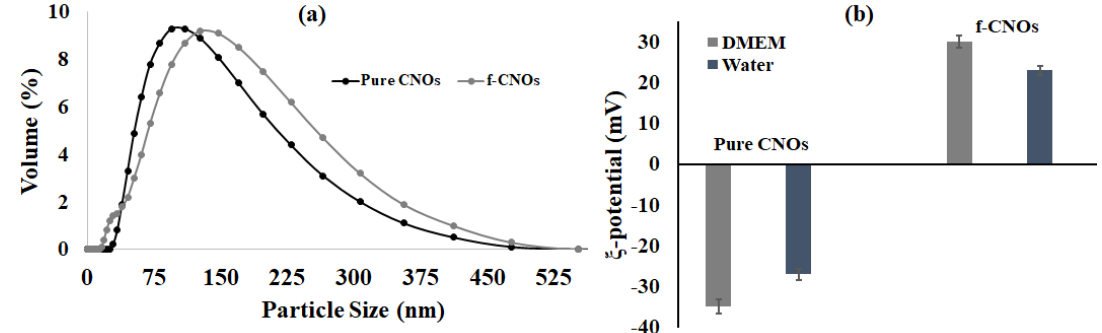
Figure 2. ( a ) Illustration of DLS particle size distribution, and ( b ) ξ -potential measurement of pristine CNOs and f-CNOs dispersions in DMEM.